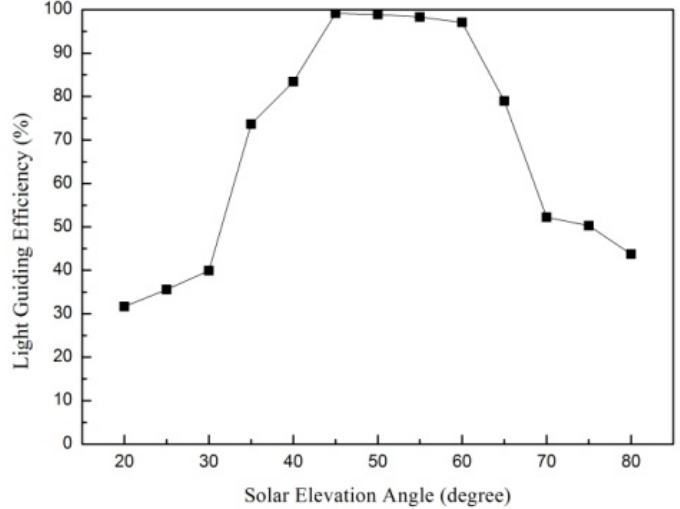
Figure 8. Light-guiding efficiency of the proposed sunlight guiding panel after structural optimization.